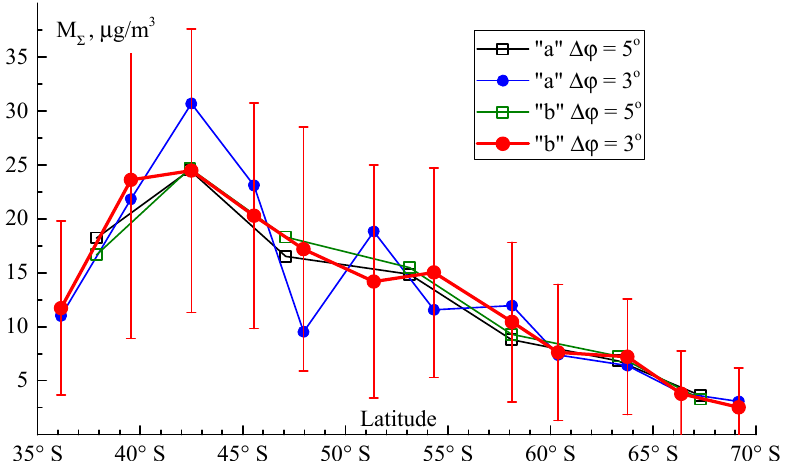
Figure 10. Latitude change of the summed concentration of ions in aerosol composition over the ocean between Africa and Antarctica in different variants of calculation (a and b) and (3° and 5°) averaging.